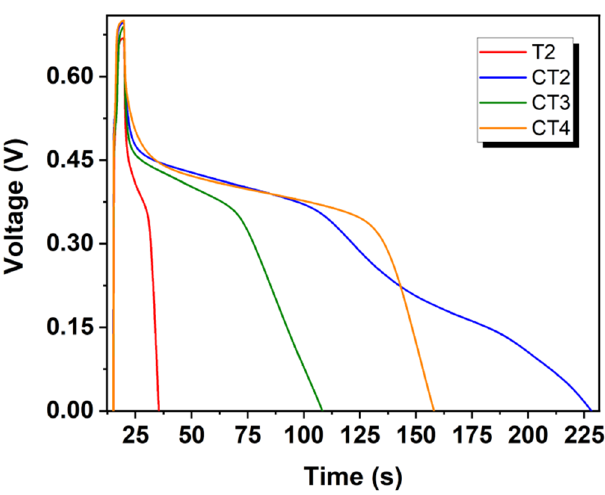
Figure 6. Galvanostatic charge–discharge curves of pure TiO 2 (T2) and Cu-TiO 2 (CT2-CT4) composites.